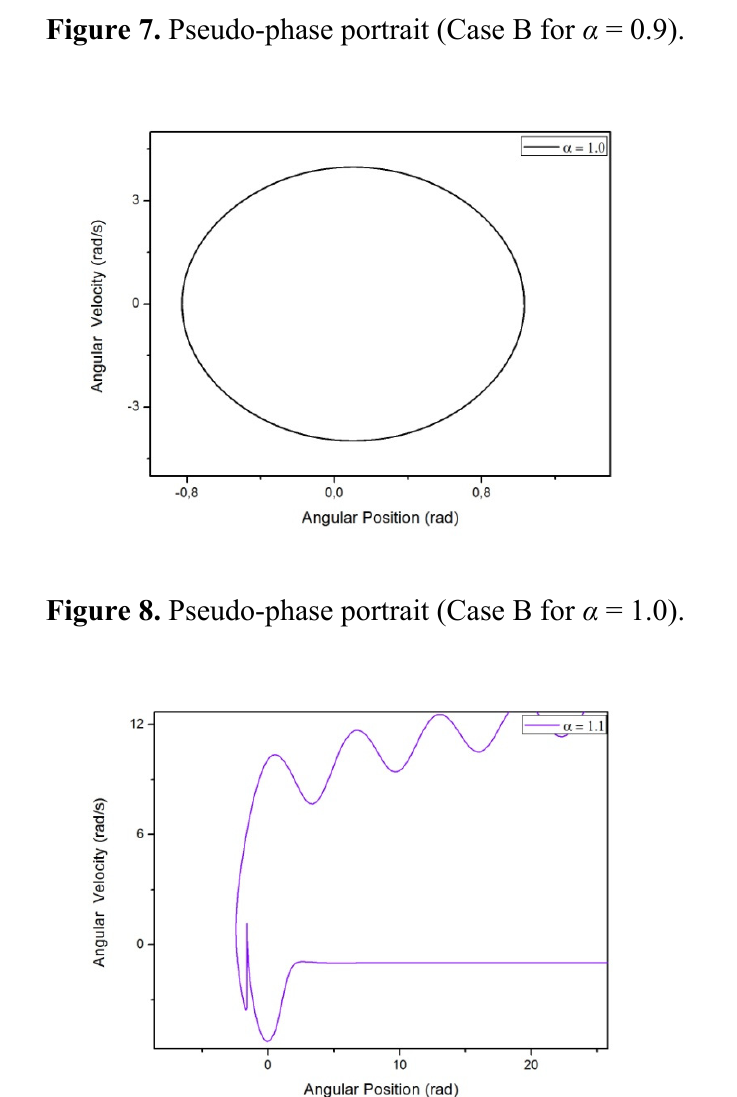
Figure 9. Pseudo-phase portrait (Case B for α =